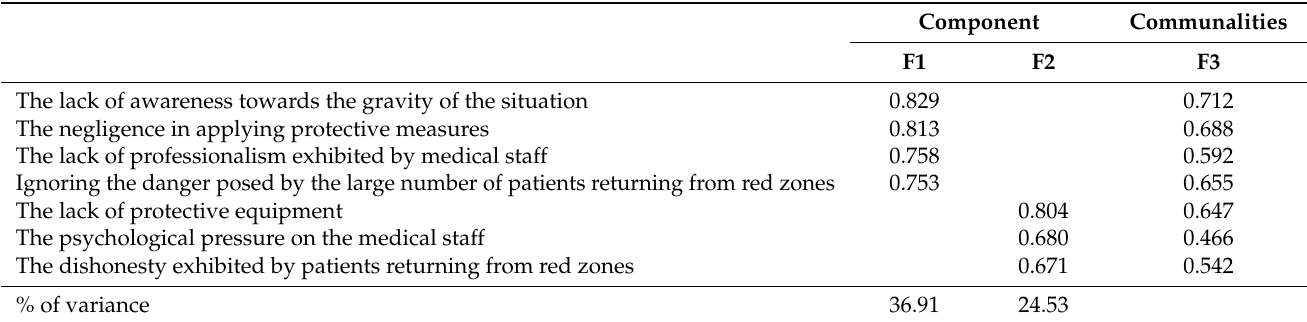
Table 2. Factor Analysis Table for the public perception of the high incidence of infection amongst healthcare professionals; Rotated Component Matrix a .